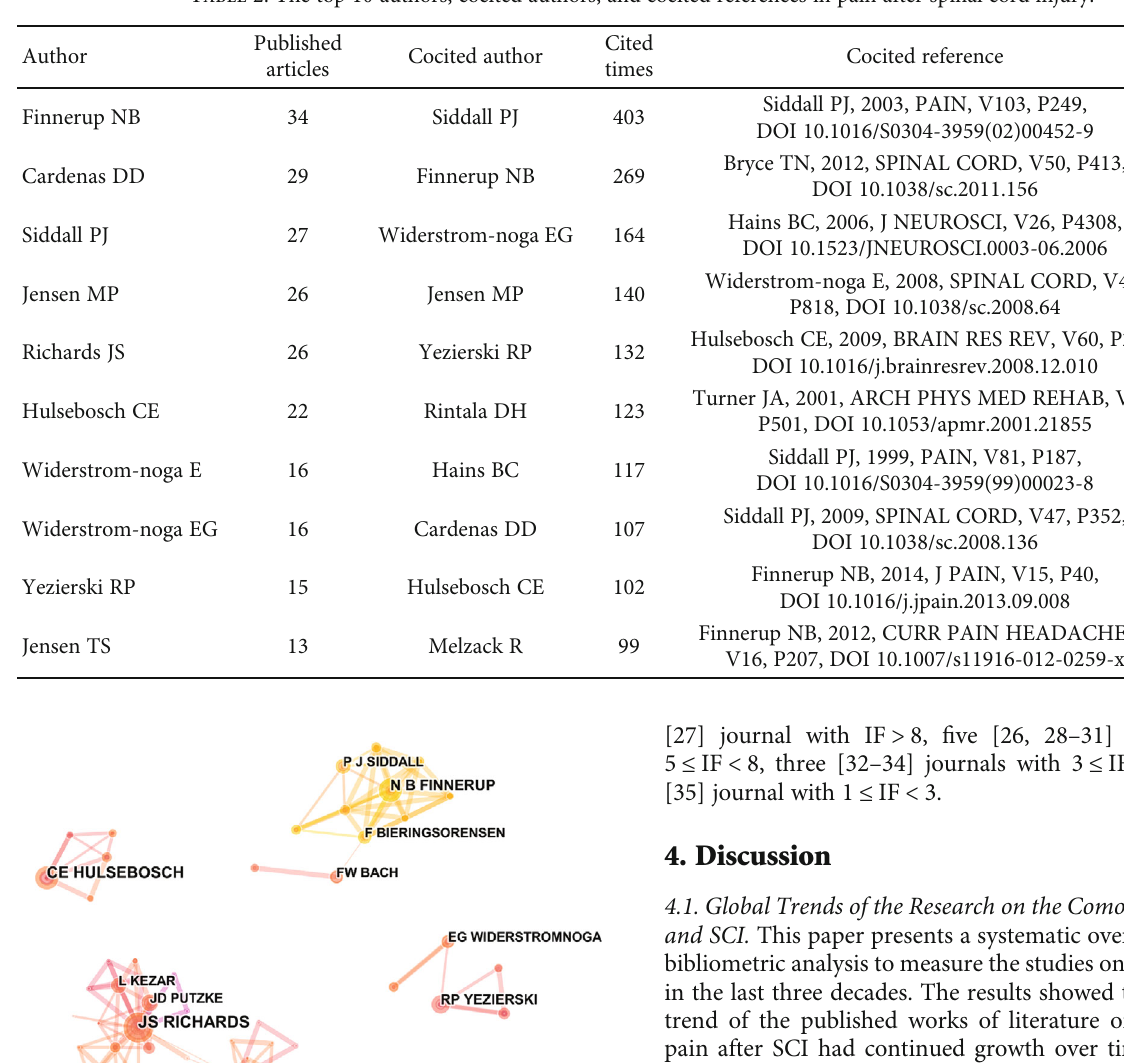
Table 2: The top 10 authors, cocited authors, and cocited references in pain after spinal cord injury.